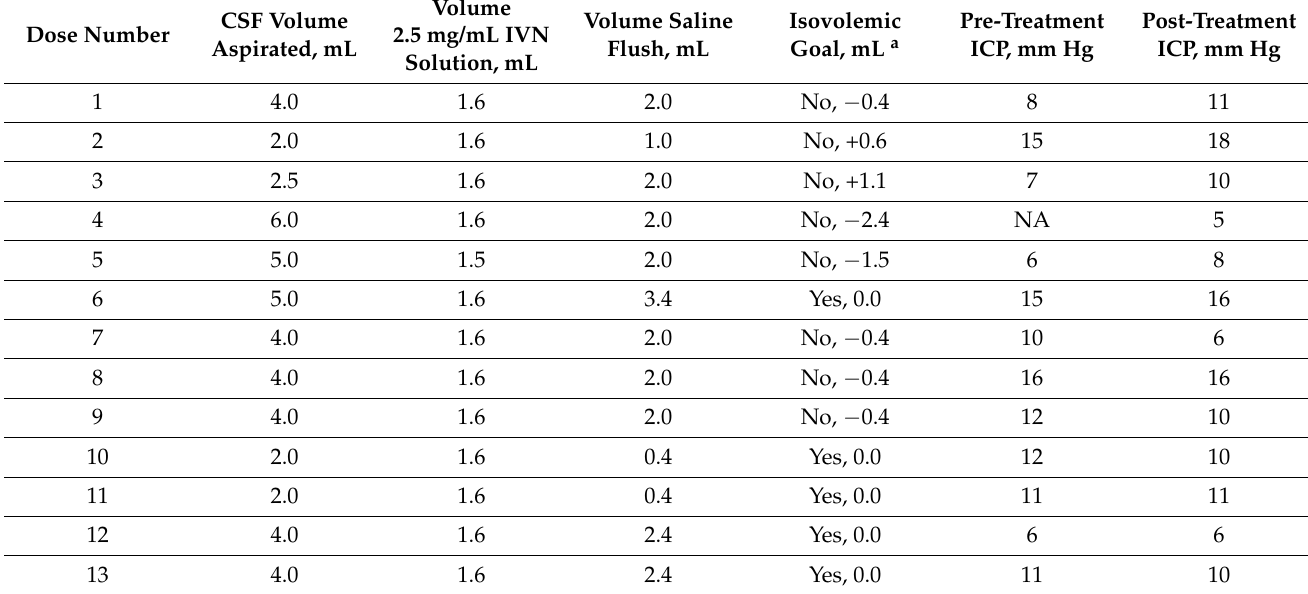
Table 2. Case 2: IVN Dosage and Related ICP Readings.